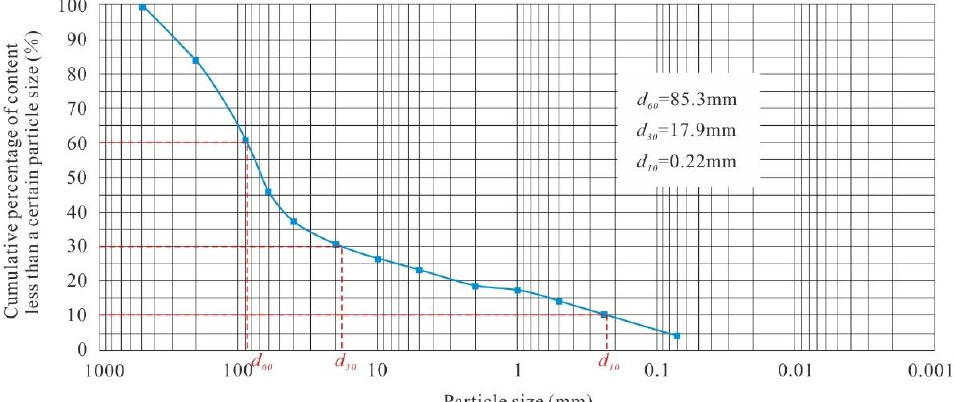
Figure 5. Gradation curve of intact glacial till samples.